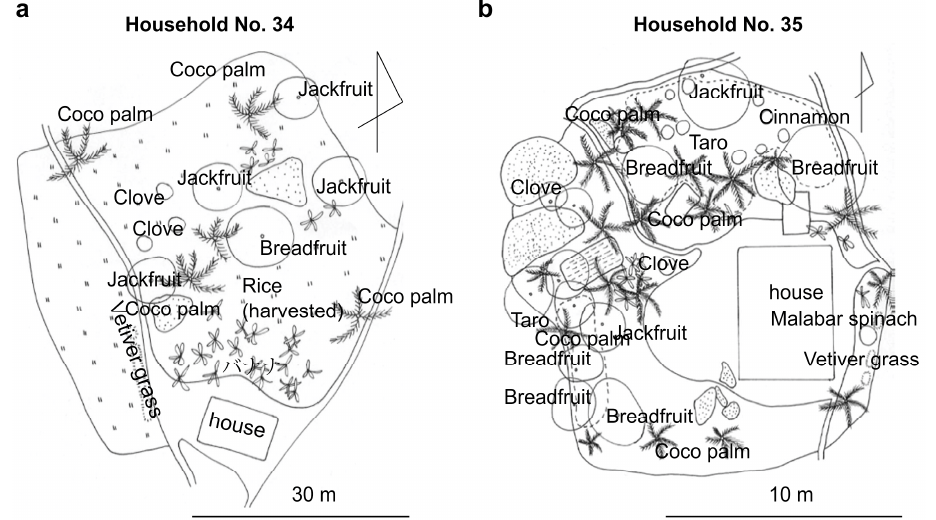
Figure 2. Schematic diagrams of the cropping patterns among neighboring homegardens (Ludewa).